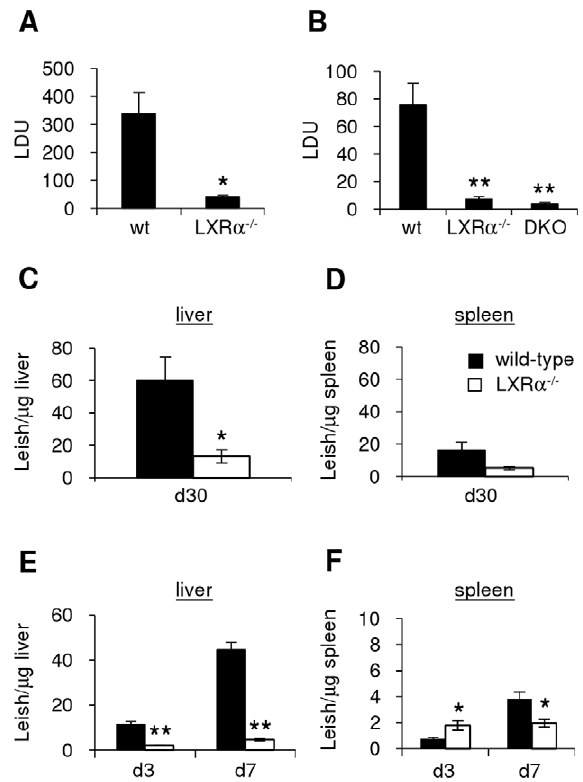
Figure 1. LXR-deficient mice display enhanced resistance to Leishmania infection of the liver and spleen. Wild-type or LXR- deficient C57Bl/6 mice (except for (B), which were the mixed Sv129xC57Bl/6 background) were challenged with 1 6 10 7 live, station- ary-phase L. chagasi/infantum parasites, and livers and spleens harvested at various time points. A–B. Parasite loads in the livers at d28 were quantitated by microscopy. Leishman-Donovan Units (LDU) = [( # amastigotes/ # mononuclear cells) multiplied by liver weight in mg]. C–F. Parasite loads in liver (C, E) and spleen (D, F) were quantitated by qPCR of genomic DNA from wild-type (black bars) and LXR a 2 / 2 (white bars) tissue. Levels are expressed as # parasites/ m g tissue. Groups consisted of 7–9 mice/group for A–D, 5 mice/timepoint for E–F. Results are representative of at least 3 independent experiments. Error bars represent standard error; * denotes p , 0.05, ** p , 0.005, p-value for Fig. 1D =0.06, comparisons to wild-type. doi:10.1371/journal.pntd.0000886.g001 intravenous challenge with L. chagasi/infantum . The amount of parasite DNA detected in LXR a 2 / 2 livers was significantly lower on both day 3 and day 7 than the amount detected in wild-type livers (Fig. 1E, d3: p = 0.002, d7: p = 0.0002). Spleens displayed relatively low overall levels of parasite DNA at early time points, but by day 7, parasite loads in wild-type spleens were significantly higher than in LXR a 2 / 2 spleens (Fig. 1F, d3: p = 0.04, d7: p = 0.02). Taken together, the differences in organ parasite loads in LXR-deficient mice suggest that LXR-regulated pathways can significantly influence the overall control of visceral leishmaniasis infections.